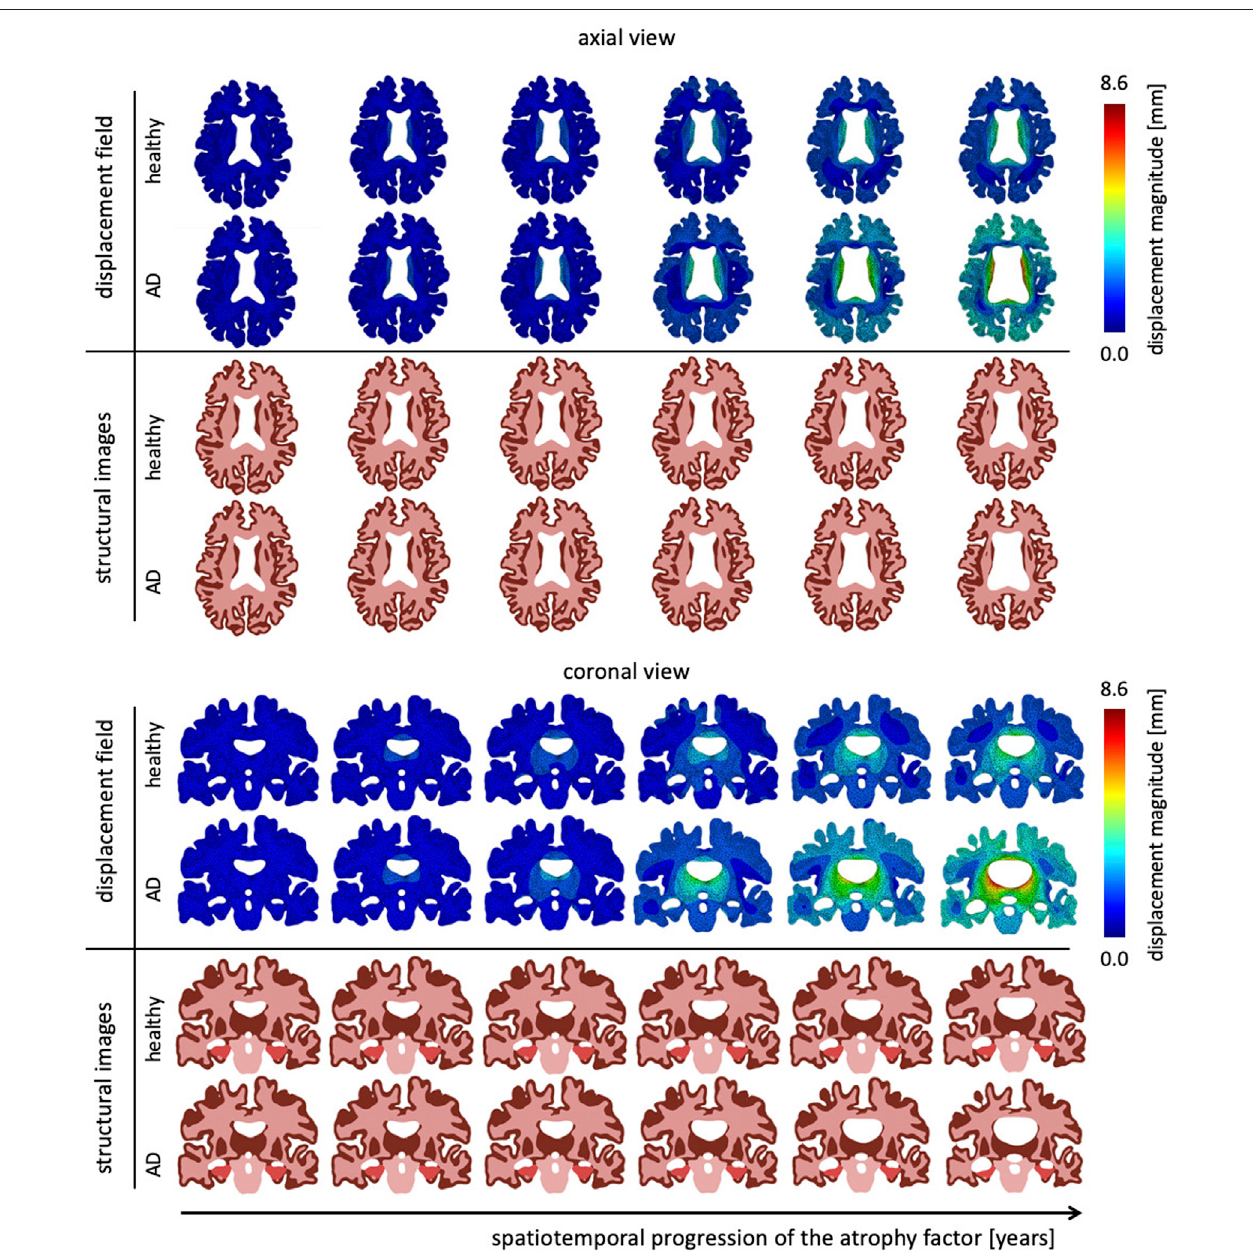
FIGURE 5 | Representative axial and coronal views of the displacement magnitude and structural images at six time points during the aging process. We show healthyagingand Alzheimer ’ sdisease-related aginginthetop andbottom rows, respectively.Brain deformationishigher inAlzheimer ’ sdisease thanhealthyaging,and islargestaroundtheventricles.Moreover,weobserve signi fi cantenlargementoftheventricularhornsinthevicinityofthehippocampus,see coronalview.Theforthtime point clearly shows a distinct separation of the displacement trajectories.